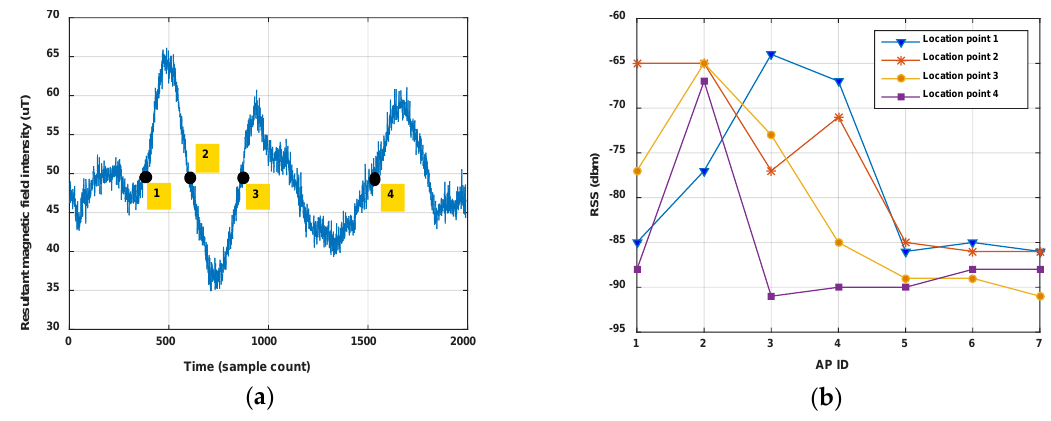
Figure 3. Comparison of the ability of location differentiation between magnetic field and Wi-Fi RSS: ( a ) Sequence of resultant magnetic field intensity in a corridor, at location points 1, 2, 3 and 4, where the intensities are same; ( b ) Difference RSS vectors at location points 1, 2, 3 and 4.